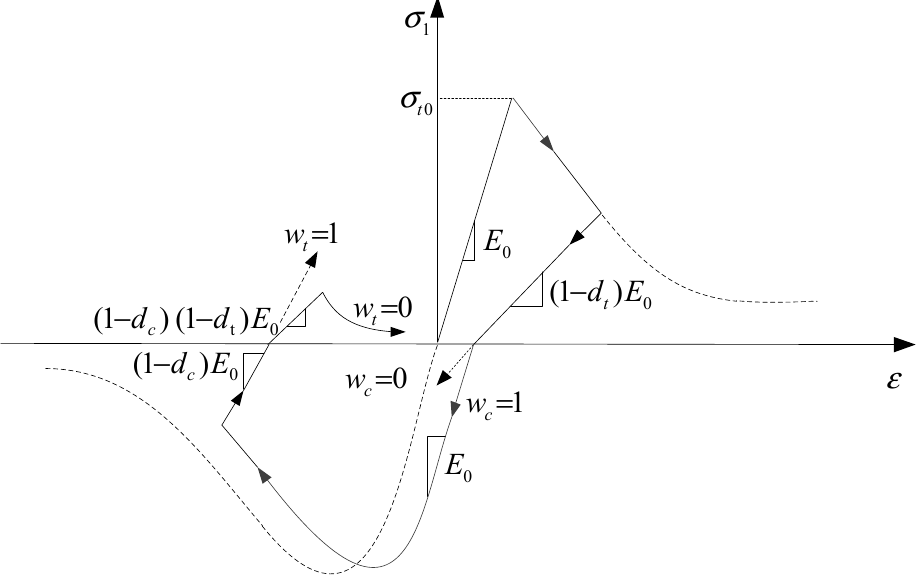
ω = , 1 ω = ). Figure 1. The stress–strain relationship under uniaxial load cycle conditions. ( ω t = 0, ω t = 1 ). t c